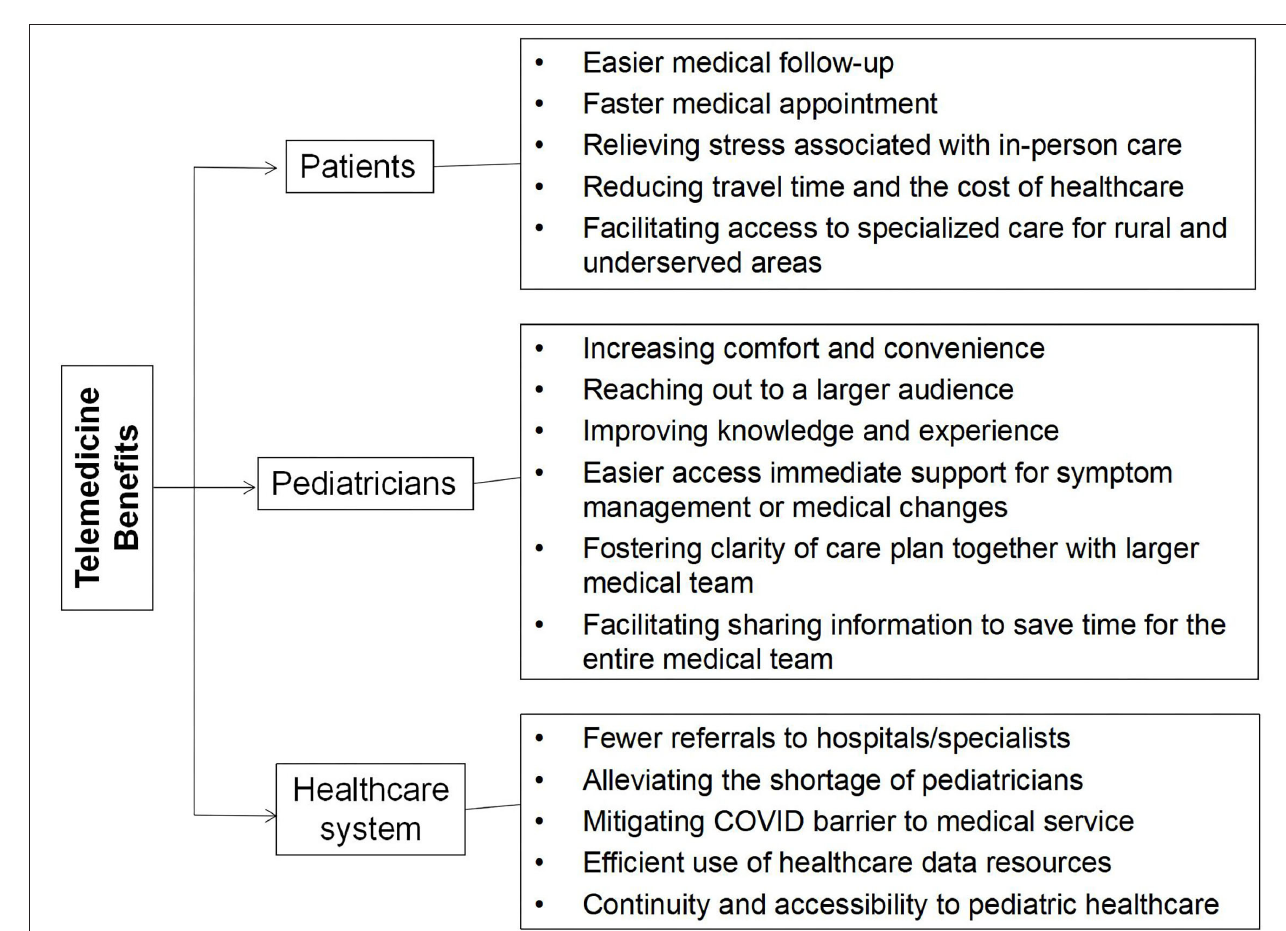
FIGURE 2 | Telemedicine benefits for patients, pediatricians and healthcare